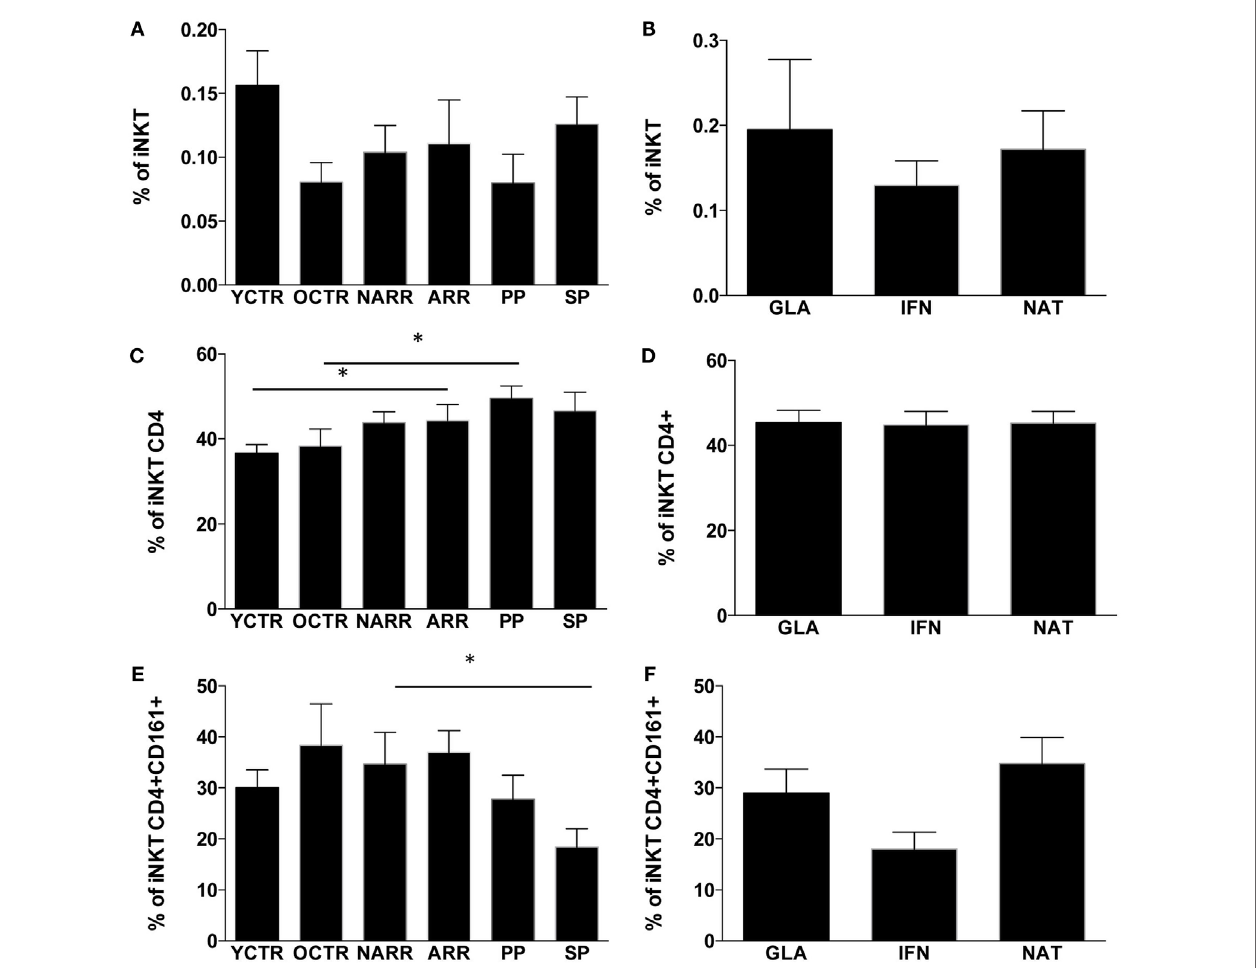
FigUre 2 | Percentages of inKT cells and their subpopulations among the different groups of Ms patients and controls . (a) Percentage of iNKT cells among patients with different multiple sclerosis form; (B) percentage of iNKT cells among RR patients treated with different immunomodulatory drugs; (c) percentage of CD4 + iNKT cells among patients with different multiple sclerosis forms; (D) percentage of CD4 + iNKT cells among RR patients treated with different immu nomodulatory drugs; (e) percentage of CD4 + iNKT cells expressing CD161 + among patients with different multiple sclerosis forms; (F) percentage of CD4 + iNKT expressing CD161 cells among RR patients treated with different immunomodulatory drugs. ARR, active relapsing–remitting; NARR, untreated patients with not-active RR; PP, untreated primary progressive; SP, secondary progressive; GLA: RR patients who had been treated for at least 6 months with either glatiramer acetate (GLA), or with beta-interferon-1a (IFN) or with natalizumab (NAT). YCTR: donors whose age was < 46 years; OCRT: controls > 46 years. Quantitative variables were compared with non-parametric Mann–Whitney U -test. * p Values < 0.05 were considered statistically significant. Data are represented as the mean ±